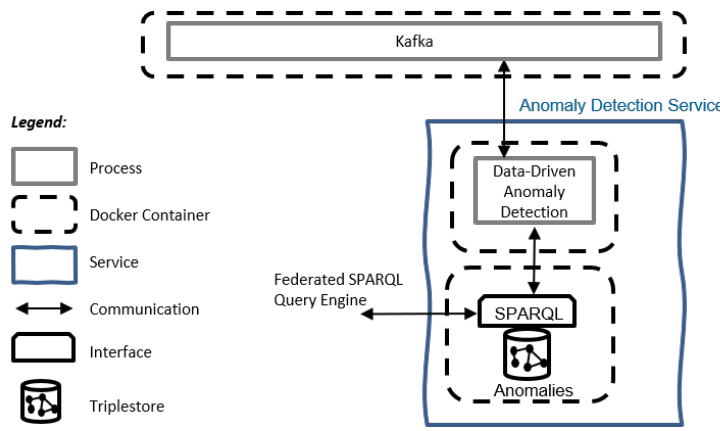
Figure 6. Anomaly Detection Service.